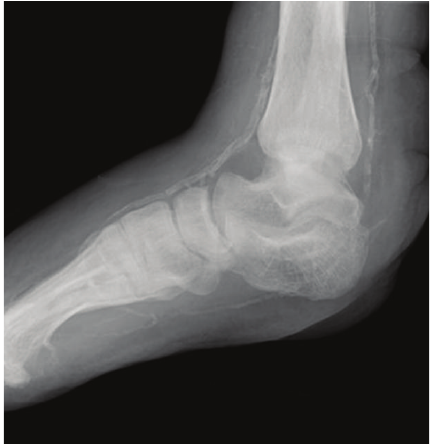
Figure 6: Category 2 partial